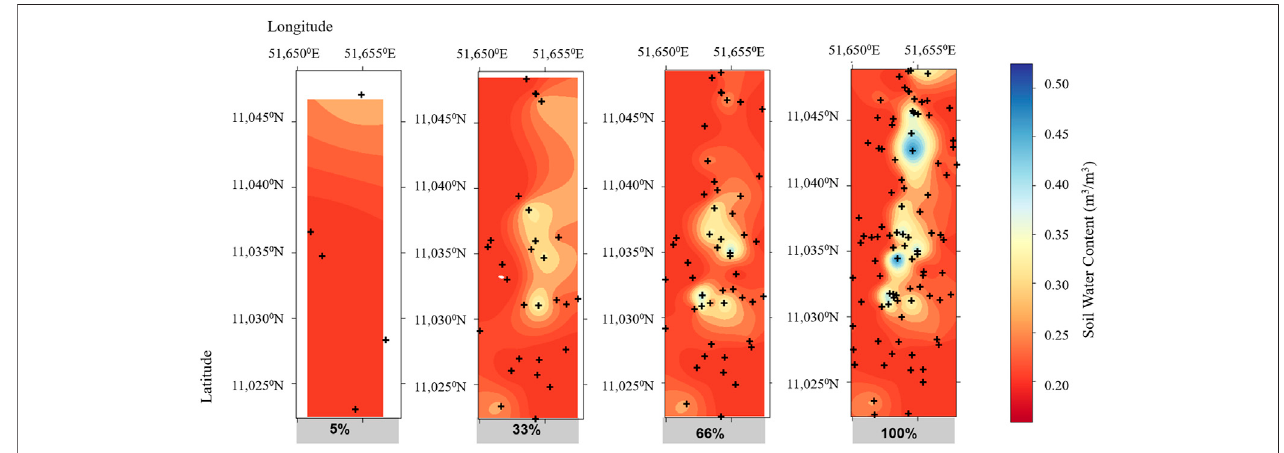
FIGURE 7 | Random selection of data points with a de fi ned percentage of source data and kriging (linear slope (cid:1) 1 and anisotropy (cid:1) 1.0).